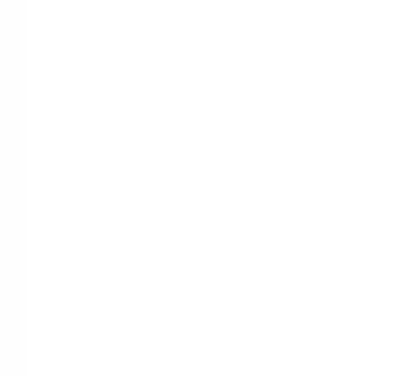
Figure 12. ROC curves of different combinations of modules in the proposed method on all test image sequences containing Seq.1–6. Table 4. Ablation study on different combinations of modules in the proposed method ( F a = 0.01%).